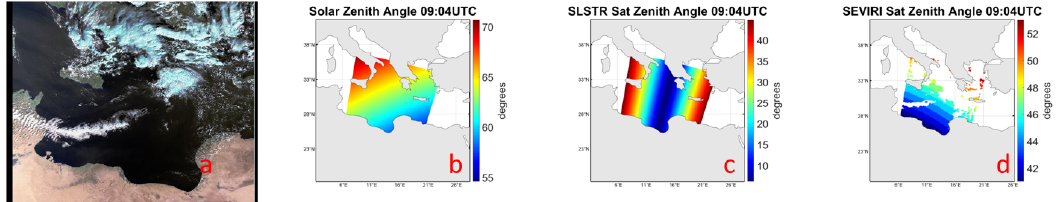
Figure 9. ( a ): SLSTR daytime false color infrared image of the Mediterranean Sea region on 23 December 2019, 09:04:56 UTC. ( b ): Solar zenith angles data at the same time. ( c ): Corresponding SLSTR satellite zenith angles. ( d ): Corresponding SEVIRI satellite zenith angles, only the points with available SEVIRI matched up pairs are shown.